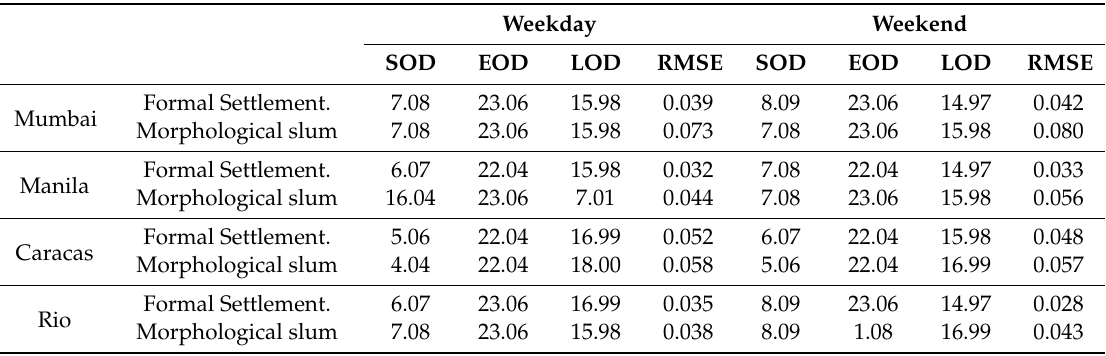
Table 2. Trajectory derivates and root-mean-squared error (RMSE) of the spline fitted